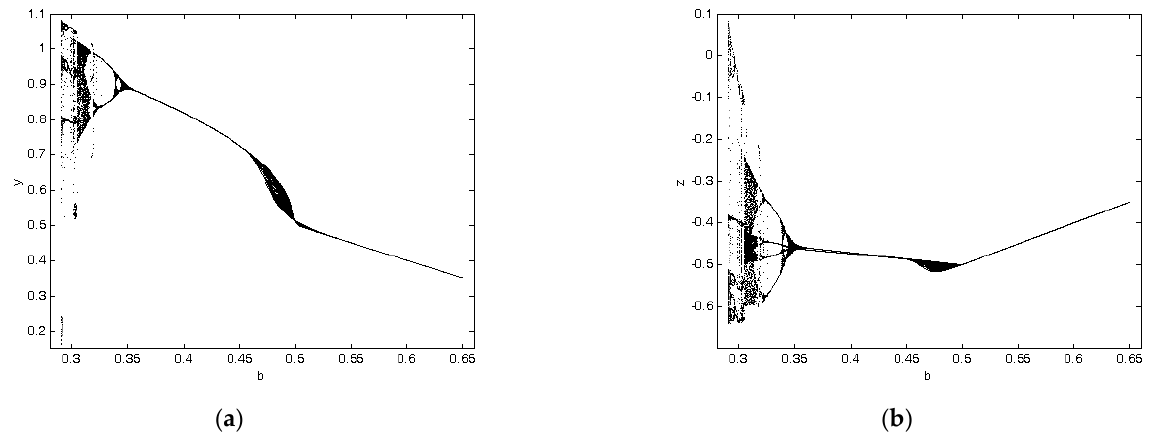
Figure 4. Bifurcation diagrams: ( a ) y ( t ) versus b ; and ( b ) z ( t ) versus b , generated by computer solution of the system (1) at a = − 1. The initial conditions are x ( 0 ) = y ( 0 ) = z ( 0 ) = 0.1. Note that b ∈ [ 0.29,0.65 ]